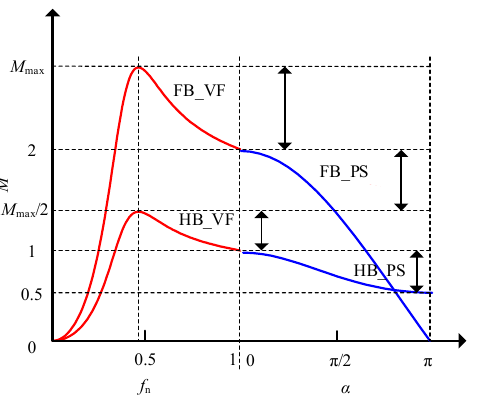
Figure 15. The overall gain curve of the new wide-output resonant converter.